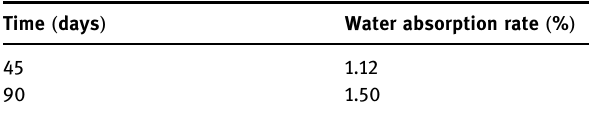
Table 2: Water absorption